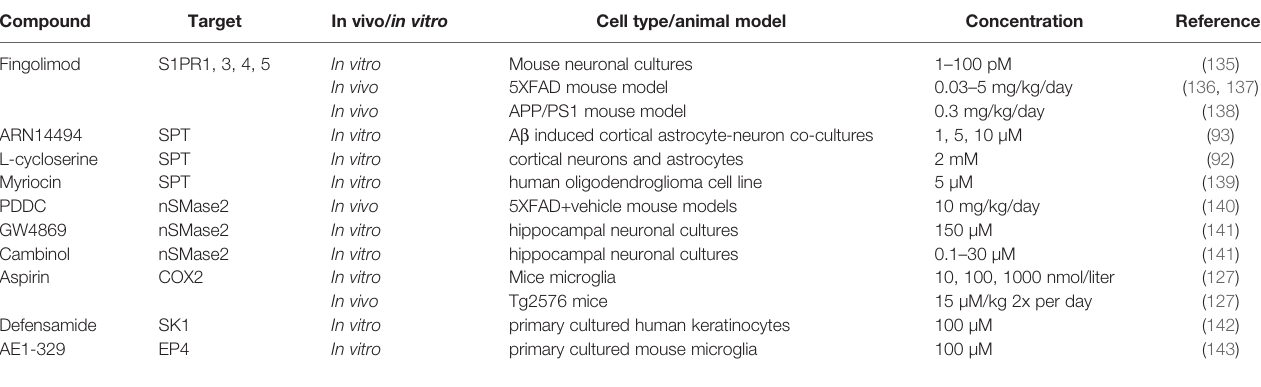
TABLE 1 | Sphingolipid and SPM based therapeutic approaches for AD.